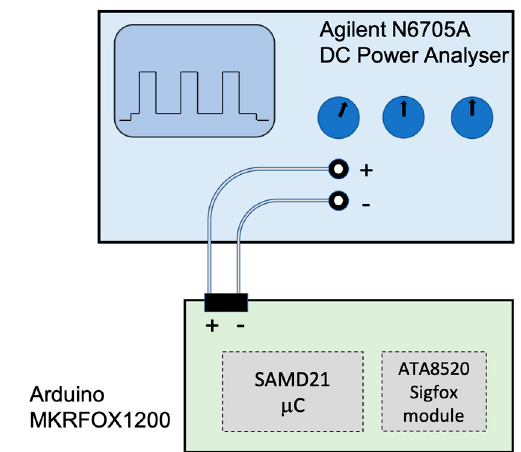
Figure 4. Experimental setup for the current consumption characterization of the MKRFOX1200 Sigfox module (on the left) using an Agilent N6705A power analyzer.